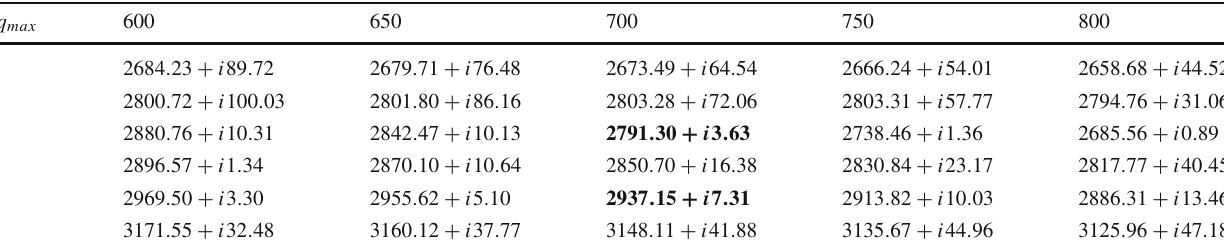
Table 10 Poles in the J P = 1 / 2 − sector from pseudoscalar-baryon interaction (all units are in